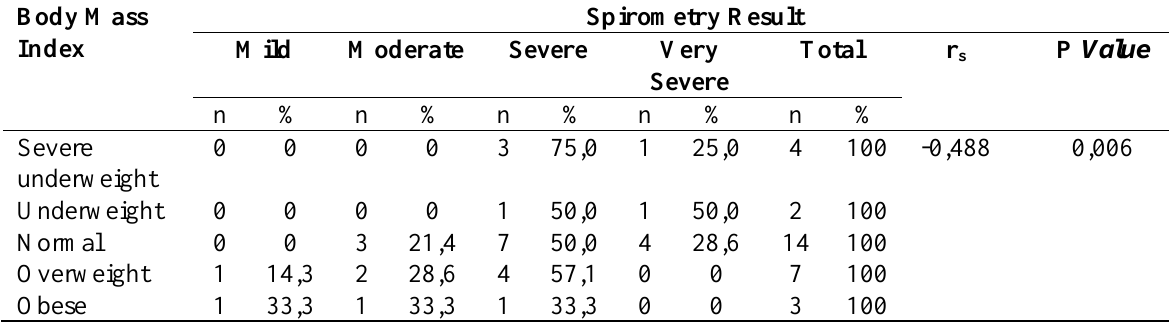
Table 6. The Relation between Body Mass Index and Spirometry Result Body Mass